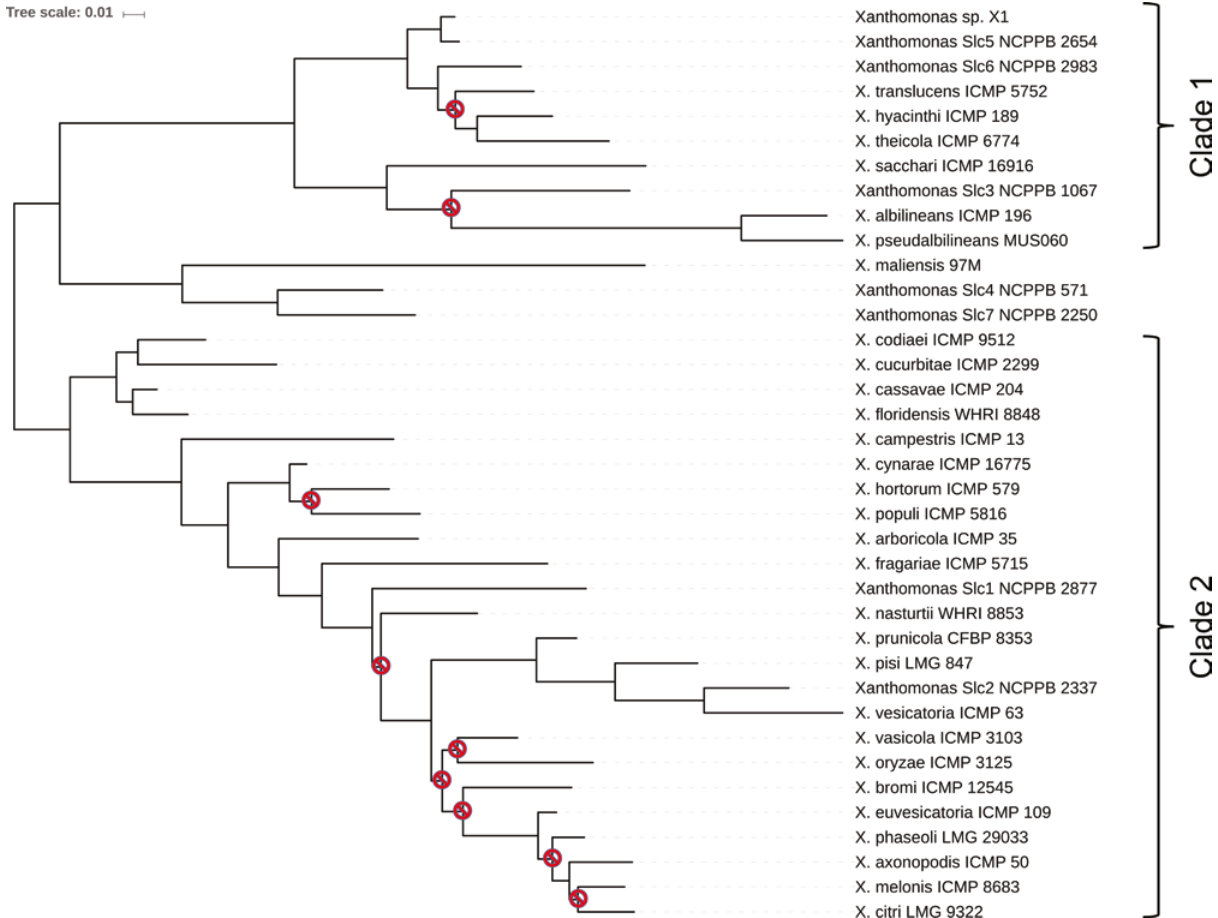
Figure 2. gyrB -based phylogenetic classification of the Algerian wheat-associated xanthomonads. Representative strains of all species fol- lowing taxonomic revisions of Xanthomonas gardneri and X. axonopodis species complex are included (Constantin et al. , 2016; Timilsina et al. , 2019). Taxonomically unassigned species-level clades (Slc 1–7) are indicated (Parkinson et al. , 2009). All sequences were trimmed to the portion that is available in GenBank for the Xanthomonas phaseoli type strain (528 bp, Accession number KT585789). The tree was con- structed with the Phylogeny.fr pipeline, using default parameters, and graphically edited using the iTOL suite. All nodes were supported by bootstrap values greater than 0.75, except for those marked with a stop symbol. The scale of branch lengths is indicated at the top